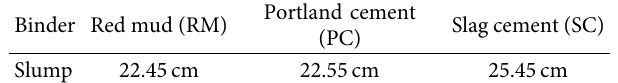
Table 5: CPB slump test results.